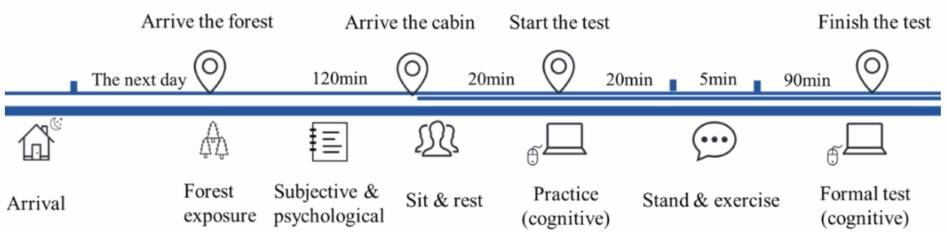
Figure 2. Procedures for the field